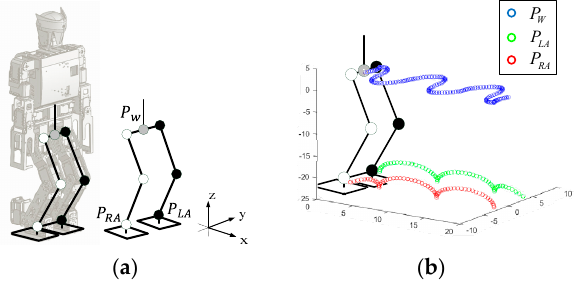
Figure 10. Legs of the humanoid robot: ( a ) coordinate system; ( b ) three-dimensional gait pattern.